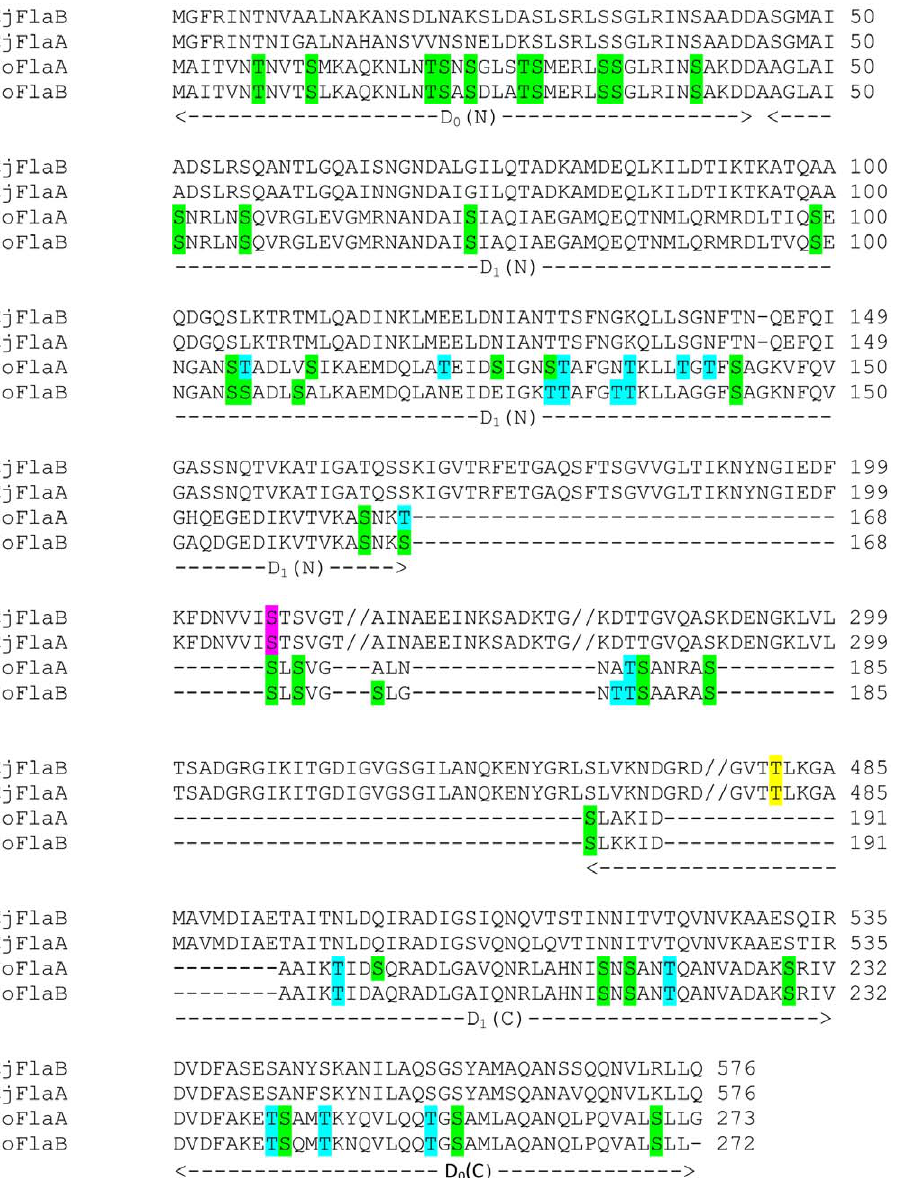
Figure 6. Potential glycosylation sites in FlaA and FlaB of S.oneidensis . S. oneidensis flagellins (SoFlaA and SoFlaB) are aligned with FlaA and FlaB of C. jejuni 81–176 (CjFlaA and CjFlaB). The domain information is based on the domains of Salmonella enterica serovar Typhimurium flagellin. Positions of the glycosylation sites of CjFlaA are in purple (S206, found in S. oneidensis ) and in yellow (T481, missing in S. oneidenisis , only one is shown). Serine and threonineresidues in S. oneidensis flagellins are in green and blue,